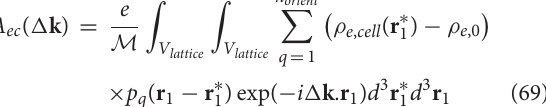
FIGURE 4 | Hexagonal lattices cross-section without (A,B) , and with (C-D) substitutional